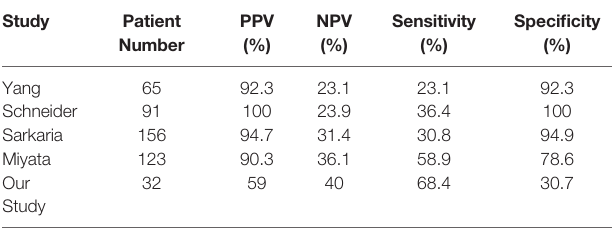
TABLE 4 | Comparison of microscopic fi ndings value of endoscopic biopsy after CRT in several studies.